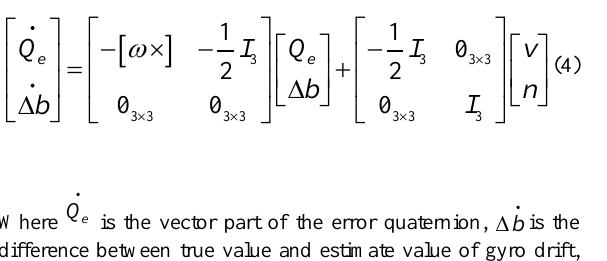
Figure 1. Sketch of attitude initial fusion based on complementary filtering The attitude fusion data based on CF are introduced as the observed values of UKF system in the process of measurement updating, which can improve the accuracy of system measurements and accelerate the rate of convergence. The fusion attitude based on CF can suppress gyro drift and attitude sensors measurement noise. Due to high measurement frequency of inertial gyro, Firstly, the attitude data is updated based on the kinematic equation by using the gyro angular velocity data. Secondly, when the star sensor attitude data is acquired, filtering system measurement is constructed based on complementary filter. Thirdly, the UKF process is implemented by using constructed system measurements. Finally, the estimated error quaternion and gyro drift increment are obtained which will be used in next loop. It is important to note that at the beginning of each filter cycle, the disturbance state (error state) need to be reset to 0. The sketch of filter method is shown in figure 2.